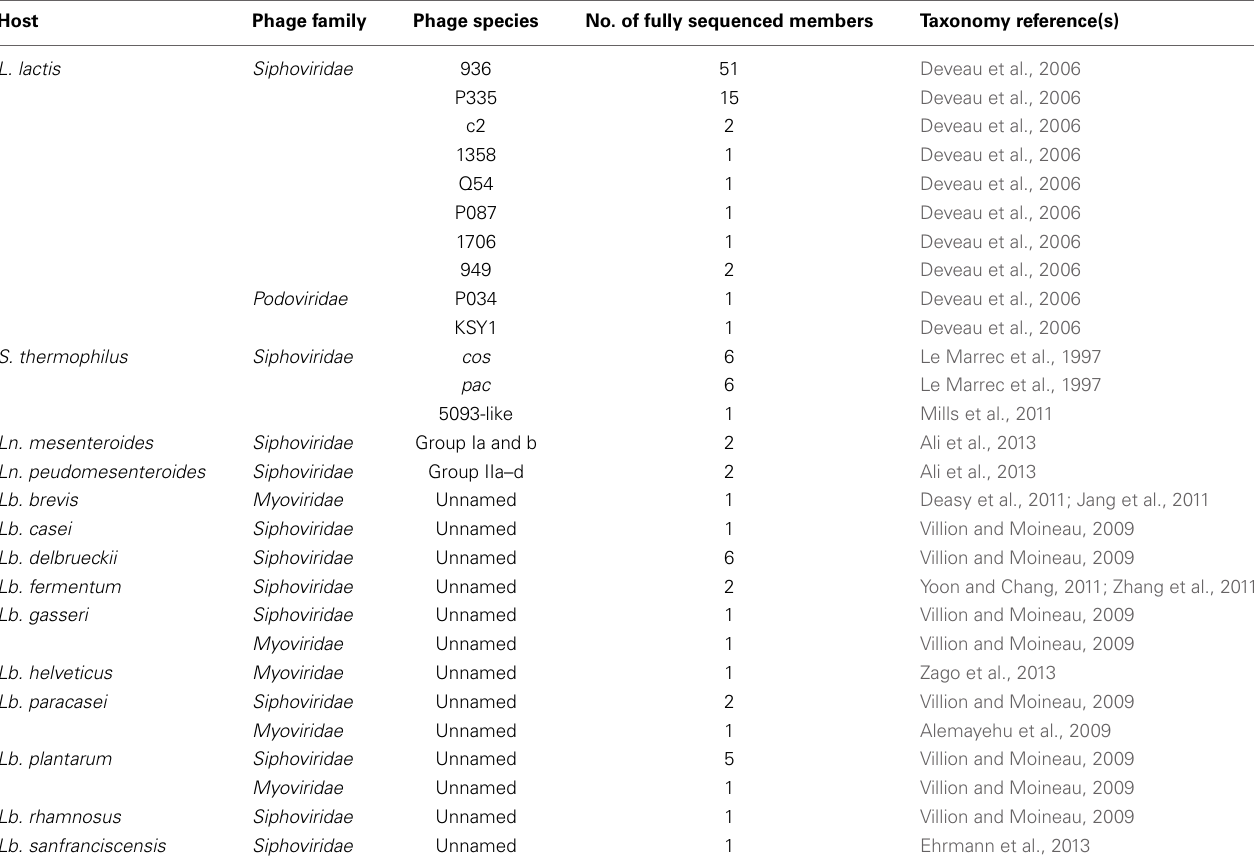
Table 1 | Current taxonomy of LAB phages with sequenced